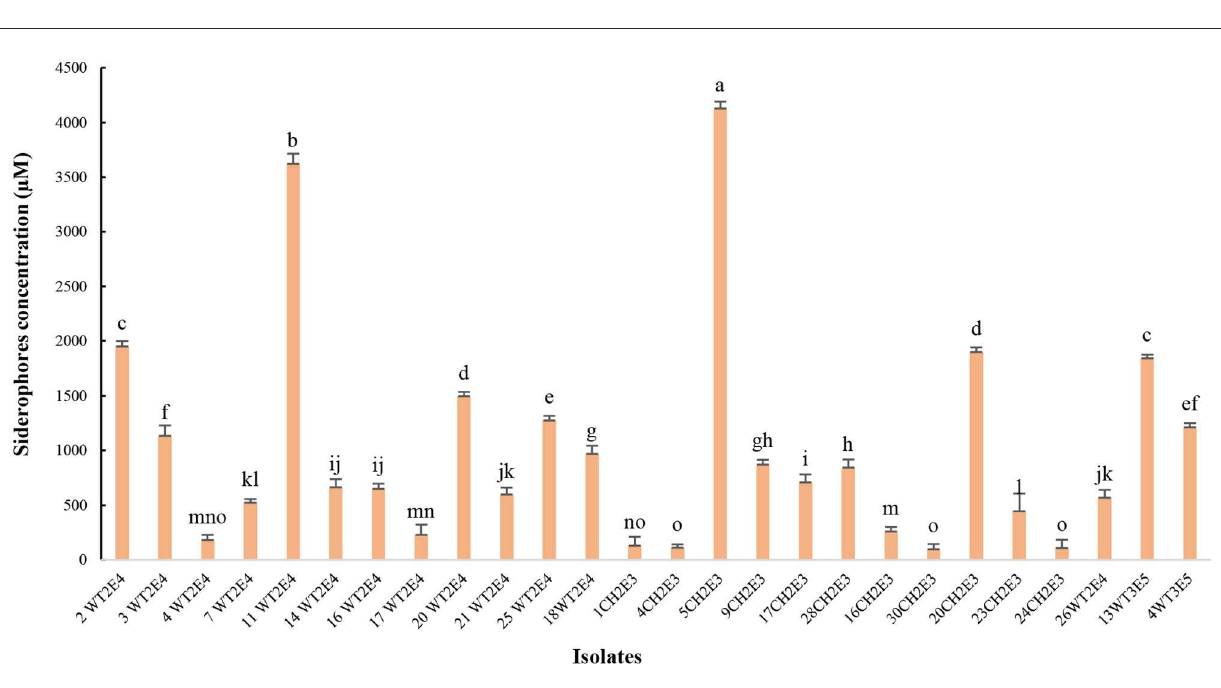
FIGURE5 Siderophores concentrations ( µ M) produced by different selected isolates. Different letters indicate that values are statistically different at a P -value of ≤